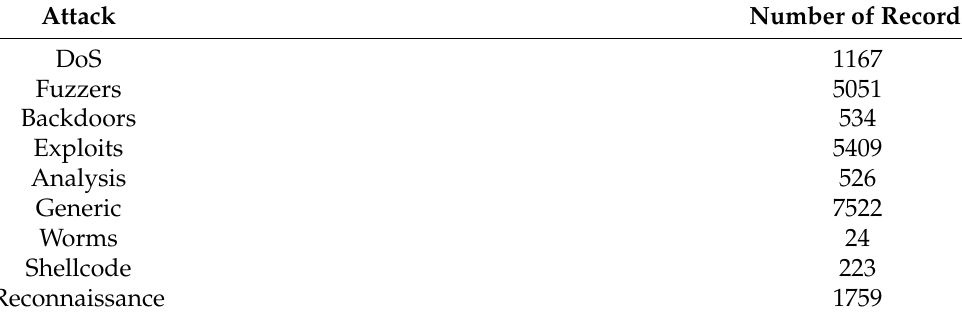
Table 4. Type of attacks in the UNSW-NB15